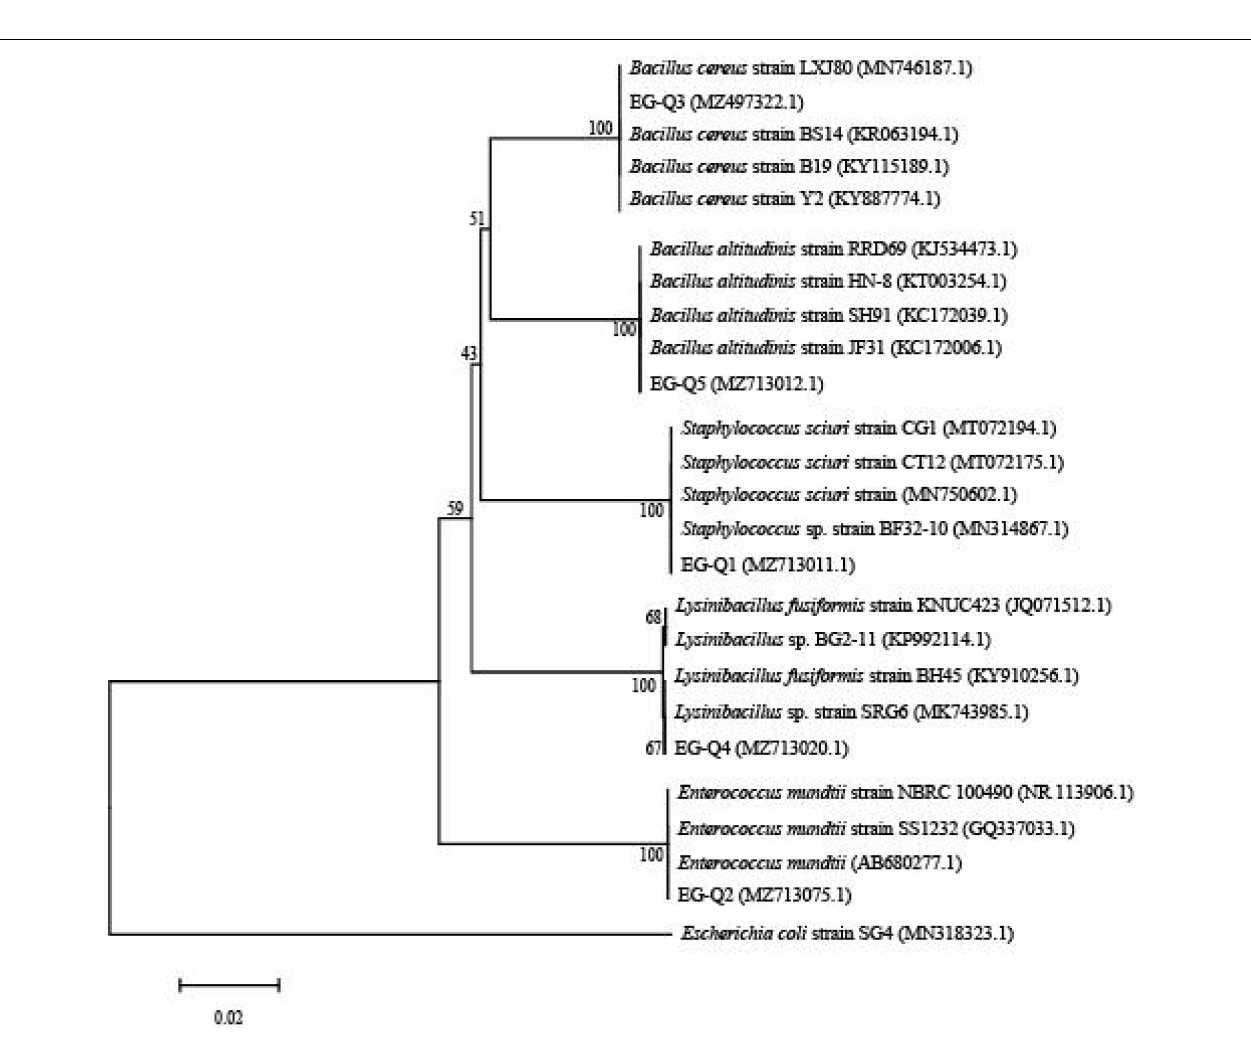
FIGURE 6 | Phylogenetic tree of the five screened